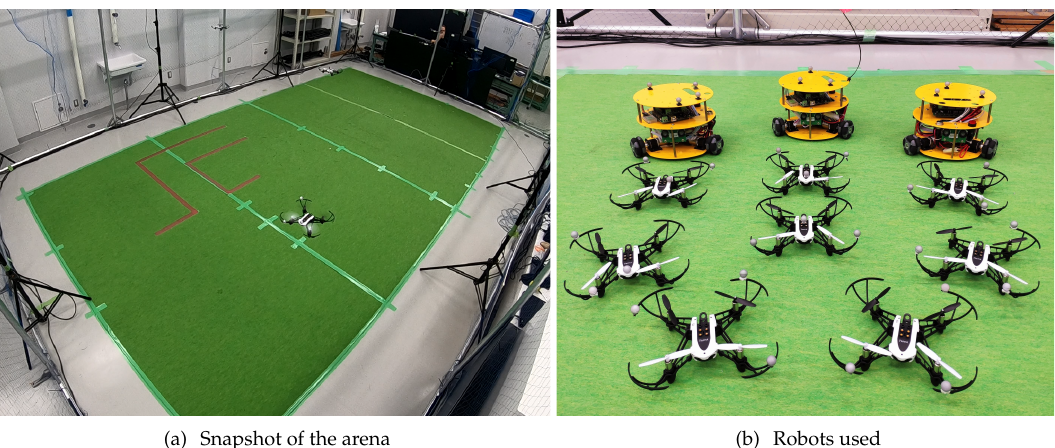
Figure 10. Test arena and robots used. In ( a ), a snapshot of the arena during a surveillance test. In ( b ), the quadcopters used (Parrot Mambo Minidrones). In the same figure appear the ground robots that were used for the case study mission, as it will be presented in Section 7.